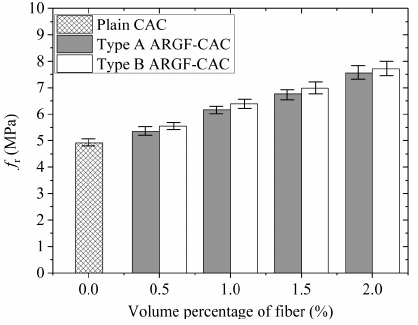
Figure 13. Variation of f r with fiber content.